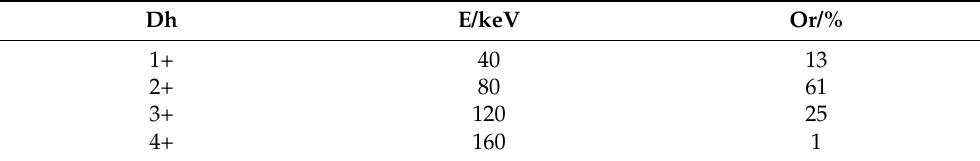
Table 1. The proportions for Ag implantation energy, E, charge state, Dh, and each charge state, Or.